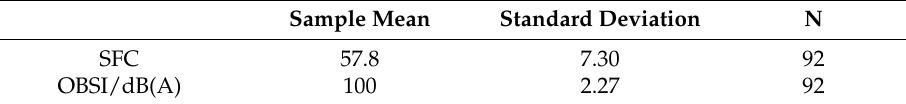
Table 8. Statistical description of side-way force coefficient (SFC) and OBSI.